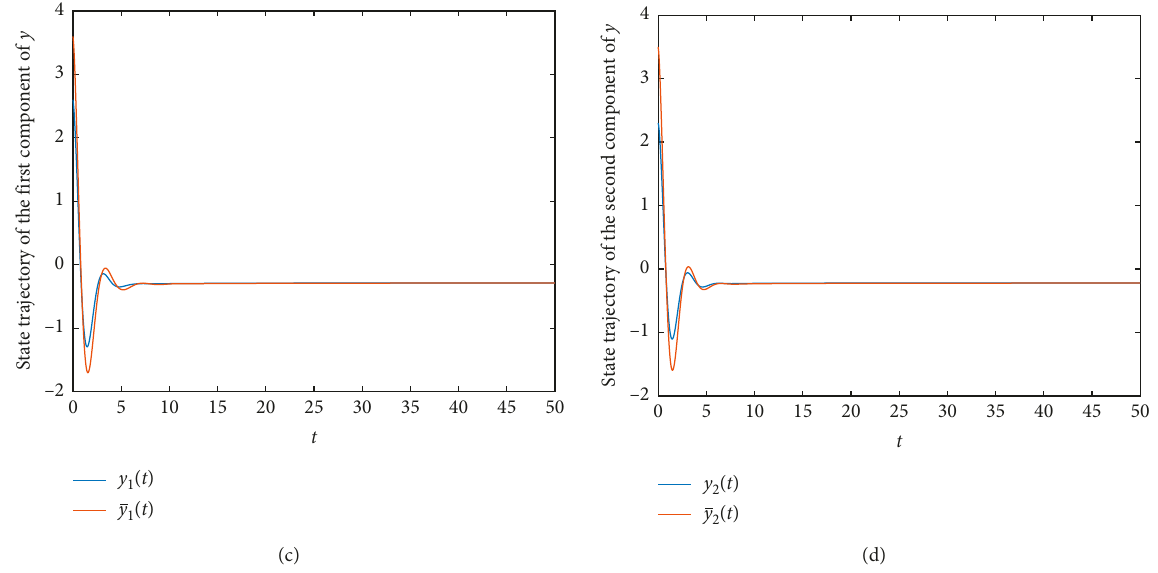
Figure 3: State trajectories of the system for two initial conditions in Example 2.